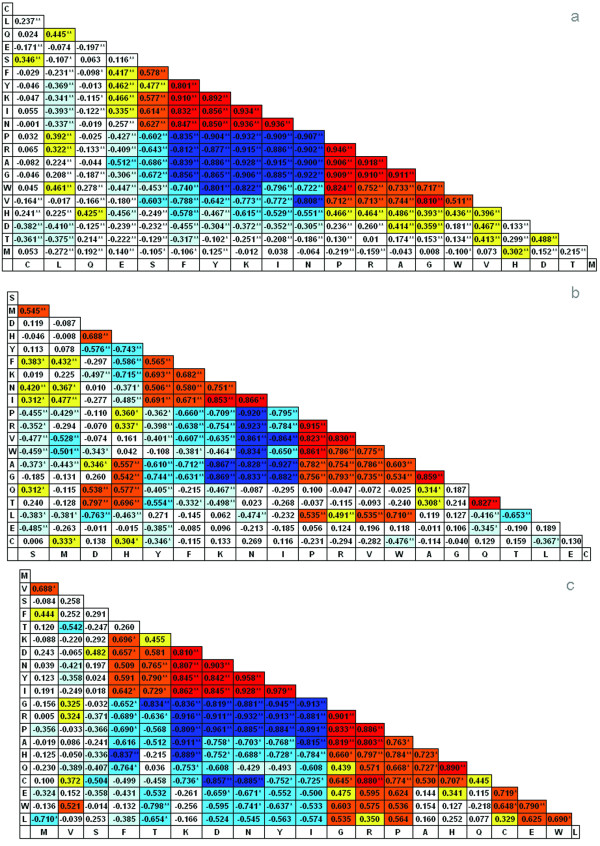
Triangle tables of correlation coefficients between amino acids. Triangle tables of correlation coefficients between amino acids in kingdoms of eubacteria (5a), archaebacteria (5b), and eukaryotes (5c). The correlations between 20 amino acids were determined by calculating Pearson correlation coefficients (r) of amino acid frequencies over 495 eubacteria, 44 archaebacteria, and 10 eukaryotic representatives respectively. Each correlation between a pair of amino acids was colored: red (r > 0.8), orange (0.5 <r < 0.8), yellow (0.3 <r < 0.5), blue (r < -0.8), light blue (-0.8 <r < -0.5), light green (-0.5 <r < -0.3) and white for others. The significance (2-tailed) was also listed in the table: ** indicates that the correlation is significant at the 0.05 level (2-tailed), and * indicates that the correlation is significant at the 0.01 level (2-tailed).